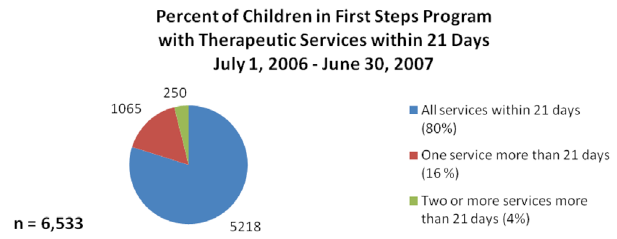
Figure 2 – Source - Kentucky Part C (First Steps) Annual Performance Report (FFY 2006);